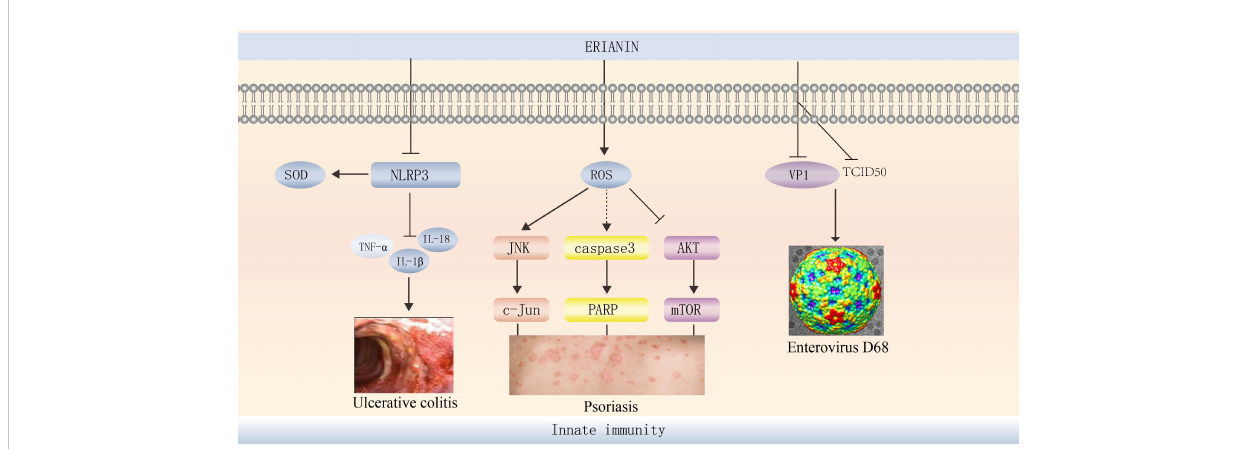
FIGURE 5 ERIANIN regulates innate immunity. ERIANIN is a speci fi c inhibitor of NLRP3 activation in vitro , reducing IL-1b, TNF- a , and IL-18 levels, up-regulating SOD levels. ERIANIN inhibits cell proliferation through the AKT/mTOR pathway and induces cell apoptosis through the ROS-mediated JNK/c-Jun and caspase3/PARP signalling pathways and then regulates the psoriasis. ERIANIN has a protective effect against EVD68-induced cell damage by inhibiting the production of human intestinal EVD68 virus by decreasing the expression of VP1 and TCID50. NLRP3, NLR family pyrin domain containing 3; SOD, superoxide dismutase; IL-18, interleukin 18; IL-1b, interleukin 1b; TNF- a , tumor necrosis factor alpha; ROS, reactive oxygen species; PARP, poly (ADP-ribose) polymerase; VP1, capsid protein 1; TCID50, tissue culture infective dose